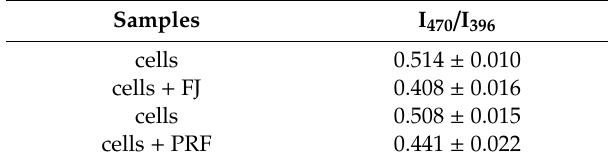
Figure 11. The emission of pyrene-labeled cells before and after incubation with V. opulus PRF ( A ) and FJ ( B ) extracts at IC 0 dosages; presented data are representative emission spectra of pyrene-labeled cells before and after incubation with PRF and FJ, n = 3. Table 2. The determined values of the ratio of excimer / monomer fluorescence intensity I 470 / I